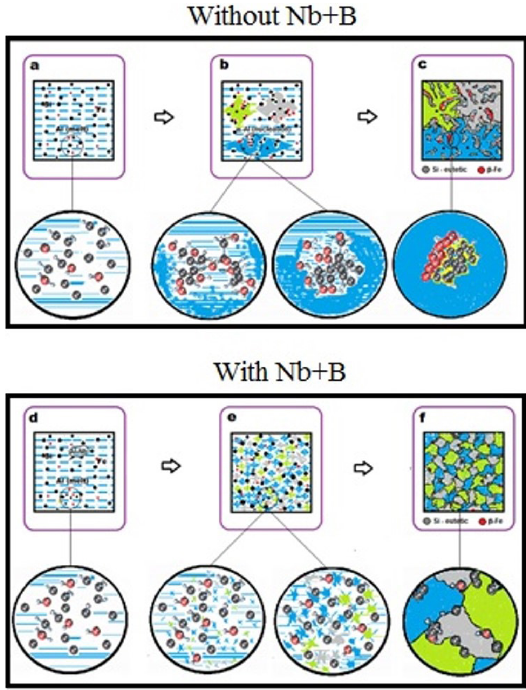
Figure 12. Illustration of the dispersion mechanism of b-Fe particles in the eutectic front of solidification of the material, without the addition of Nb+B (a, b, c), with the addition of Nb+B (d, e, f). Liquid metal (a, d). Beginning of the grain’s solidification process and growth (b, e). End of solidification (c, f). (Microsoft Paint. Ink